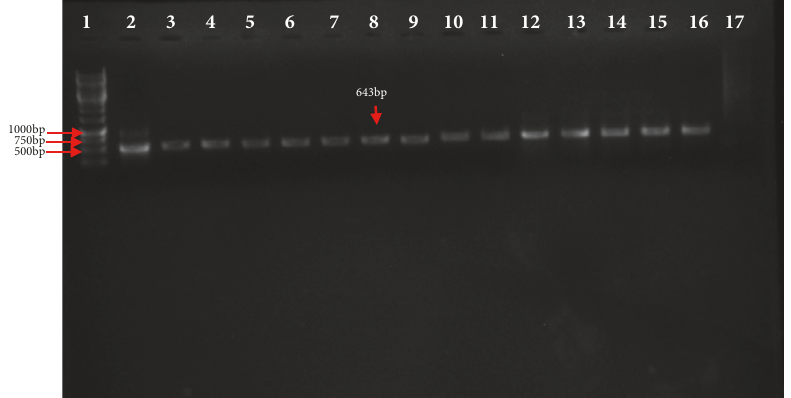
Figure 3: Gel electrophoresis of bioreactor passaged viruses. RT-PCR product showing 643 bp fragment of bioreactor passaged vvIBDV UPM0081EP12BGMP15BP1 (lane 2), UPM0081EP8BGMP1BP1 (lane 3), UPM190EP12BGMP15BP1 (lane 4), UMP190EP8BGMP1BP1 (lane 5), and original BGM-70 and egg passaged isolates UPM0081BGMP15 (lane 6), UPM190BGMP15 (lane 7), UPM0081EP8 (lane 8), UPM190EP8 (lane 9), UPM0081EP12 (lanes 10 and 11), UPM190EP12 (lanes 12 and 13), positive controls (lanes 14, 15, and 16), and negative control (lane 17). A 1000bp DNA ladder (lanes 1 and 15) (MBI Fermentas, Lithuania) was used to flank the PCR